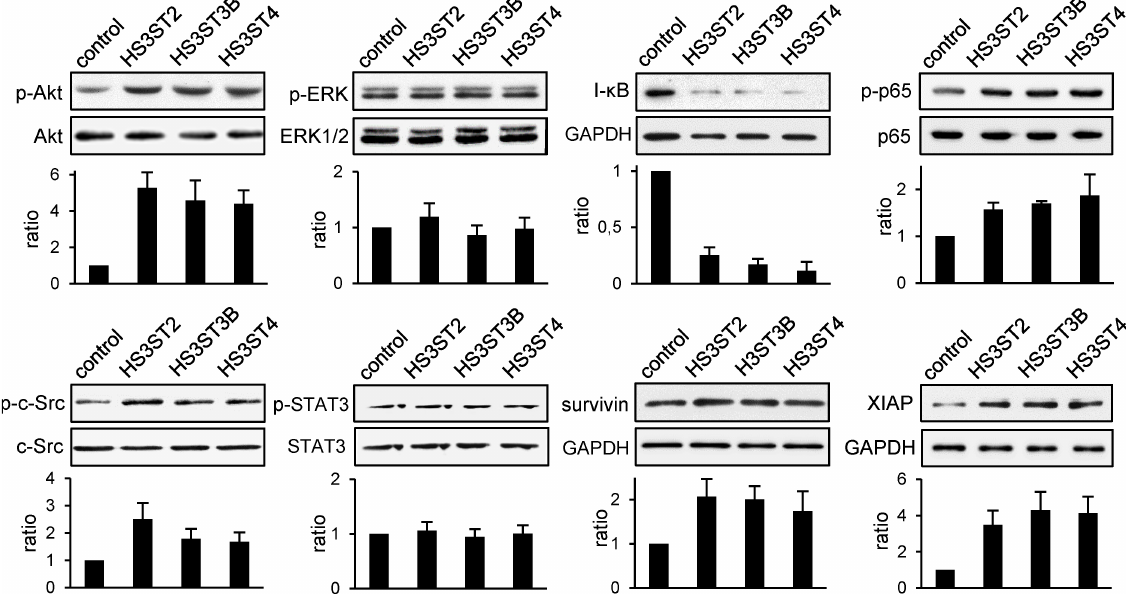
Fig 4. Effect of the expression of HS3ST2, HS3ST3B and HS3ST4 on cell signaling. Twenty hours post transfection, MDA-MB-231 cells were serum-starved for 3 hours, collected and lysed. Proteins were then separated by SDS-PAGE and subjected to Western blotting with antibodies to I- κ B, survivin, XIAP and to the phosphorylated forms of c-Src, Akt, ERK1/2, STAT3 and NF- κ B p65 subunit. Parallel immunoblotting with antibodies to GAPDH and to c-Src, Akt, ERK1/2, STAT3 and NF- κ B p65 regardless of their phosphorylation status confirmed equal loading of samples. Histograms represent the quantification of the phosphorylation status of c-Src, Akt, ERK1/2, STAT3, NF- κ B p65 and of the expression of I- κ B, survivin and XIAP related to GAPDH. Data were normalized to control cells. Representative results from three independent experiments are